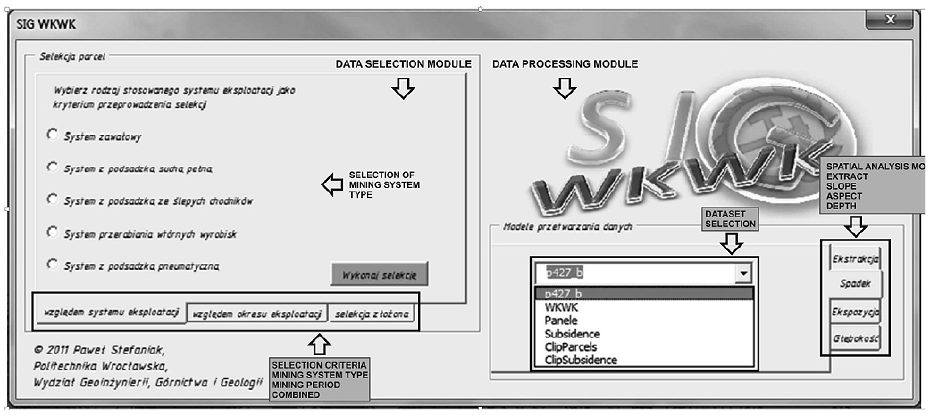
Figure 5. The spatial data analysis application in the deformation information system.